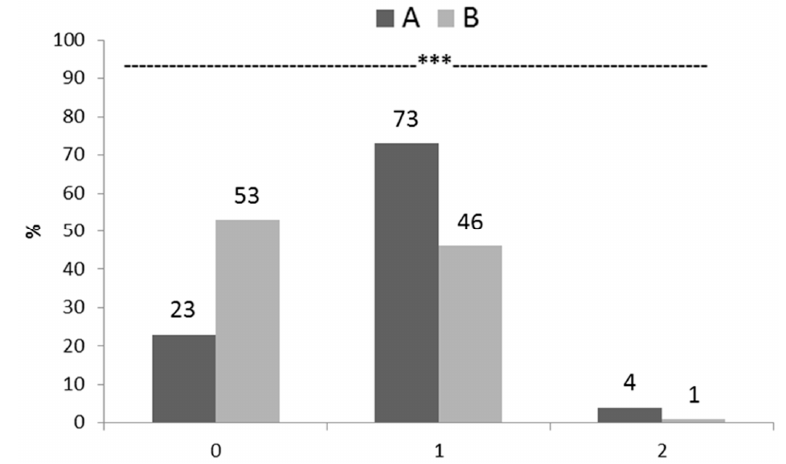
Figure 2. Incidence (%) and severity (0: no lesion; 1: mild lesion; 2: severe lesion) of foot pad dermatitis in both genotypes (A and B) at slaughtering (35 d) (*** p < 0.001).